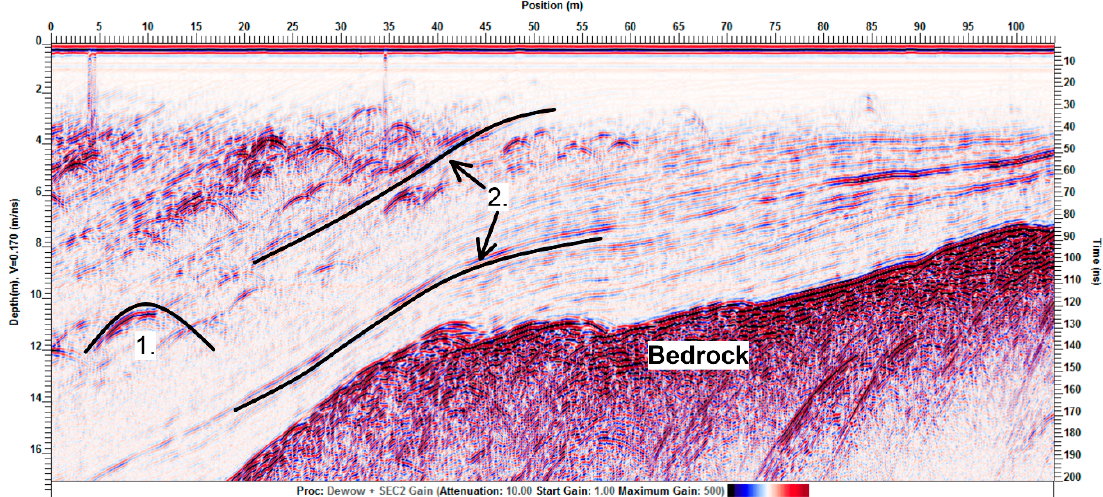
Figure 18. An example of GPR data from an alpine ice patch shown in standard seismic color scheme. The bedrock is easily distinguished from the ice, while embedded anomalies generate clear diffraction hyperbolas (e.g., 1). These were used to determine a velocity of 0.17 m/ns. Bedding is clear throughout the ice (e.g., 2) indicating that the types of ancient surfaces that might contain archaeological material would be readily detectable with GPR. Such interfaces may also contain a range of paleo-environmental material relevant to archaeology.